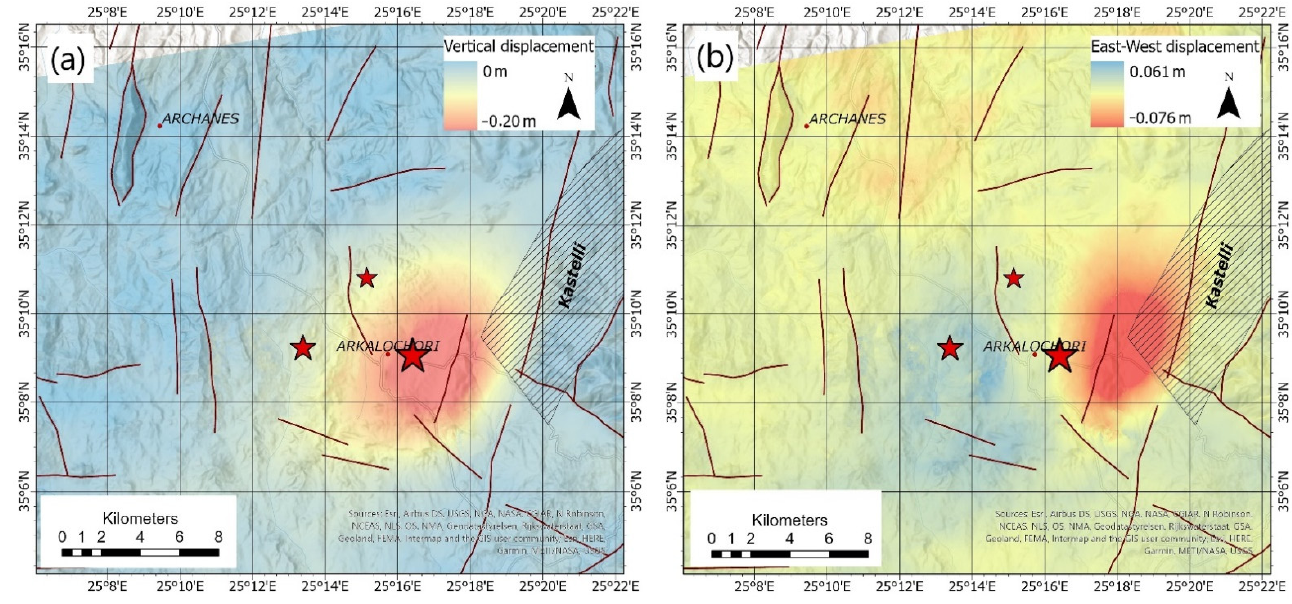
Figure 7. Displacement maps for: ( a ) the vertical (up–down); and ( b ) the E–W direction for Central Crete due to the 27 September 2021 earthquake overlain by the active faults of the broader area. The epicenters of the main event and of the two major aftershocks are shown with red stars.